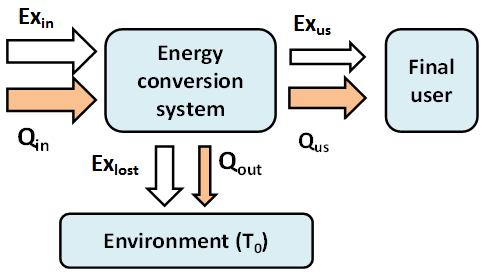
Figure 2. Energy and exergy flows, to and from an energy conversion system.